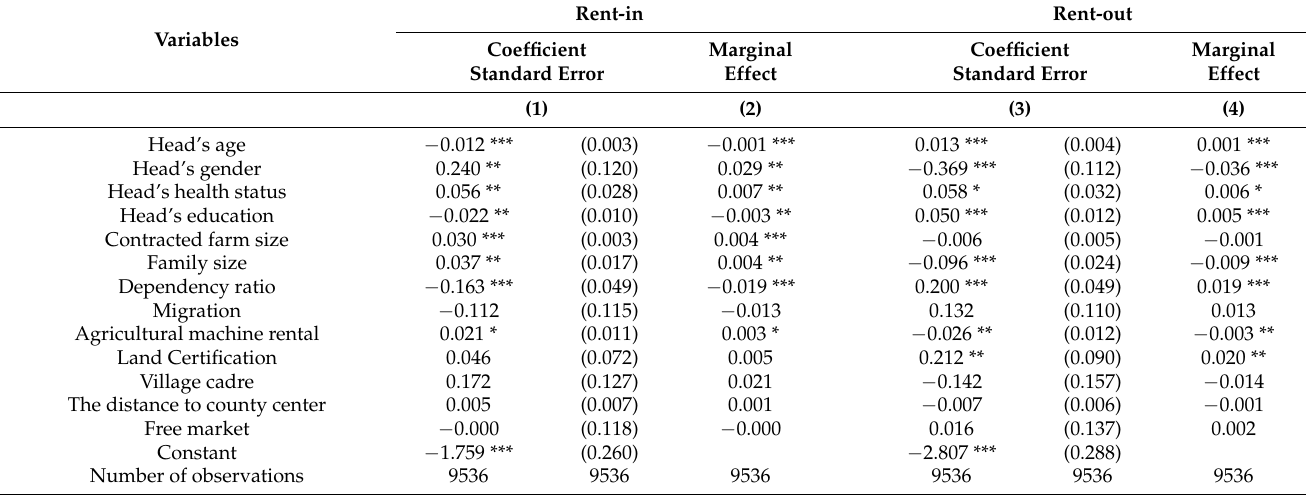
Table 2. Logit model result of factors affecting land rental